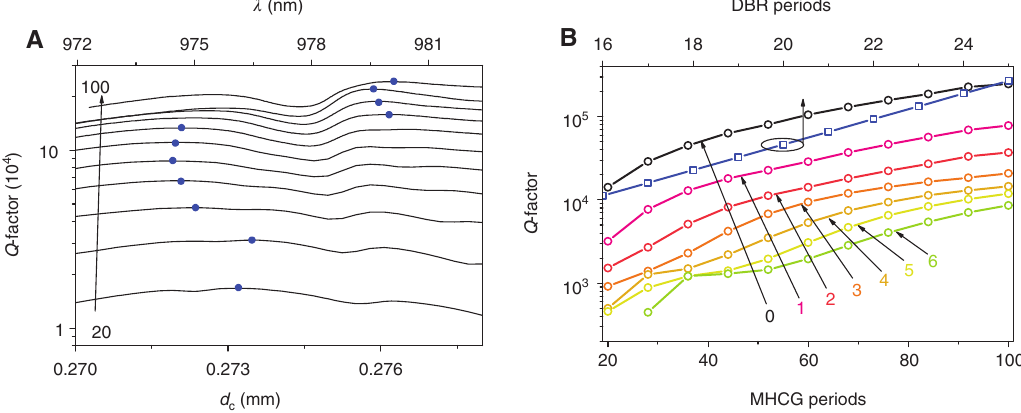
Figure 2: Q -factor of M-D microcavities as the function of cavity thickness for different number of MHCG periods in (A) and Q -factor of successive lowest order lateral modes in